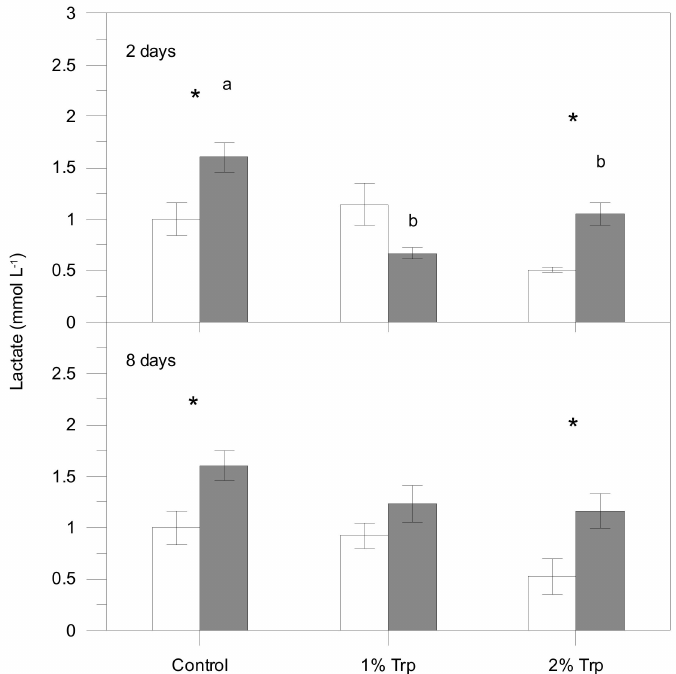
Figure 3. Plasma lactate concentration for each treatment (mean ± SE). White and grey bars are pre- and post-stress values, respectively. White and grey bars are pre- and post-stress values, respectively. Asterisks indicate significant di ff erences between pre- and post-stress conditions. Di ff erent letters indicate significant di ff erences among groups (di ff erent experimental feeds) within each sample (pre- and post-stress).